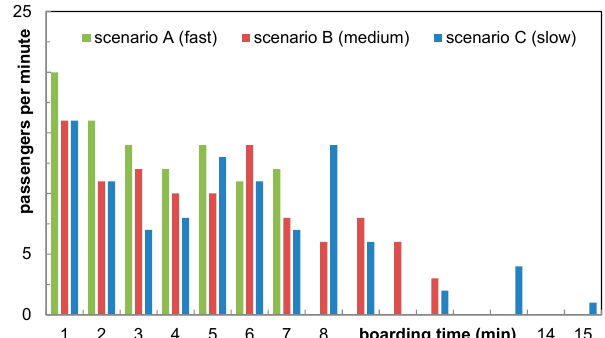
Figure 6. Progress of different boarding events measured in the field.